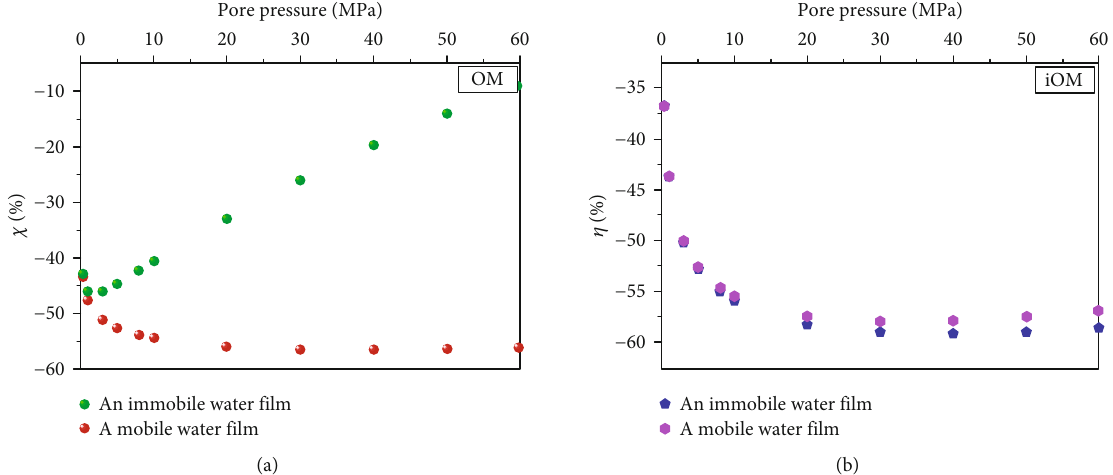
Figure 6: The di ff erences of AGP at dry conditions and moist conditions (i.e., an immobile water fi lm and a mobile water fi lm): (a) OM ( r = 5 nm, θ = 145 ° ); (b) iOM ( H 0 OM